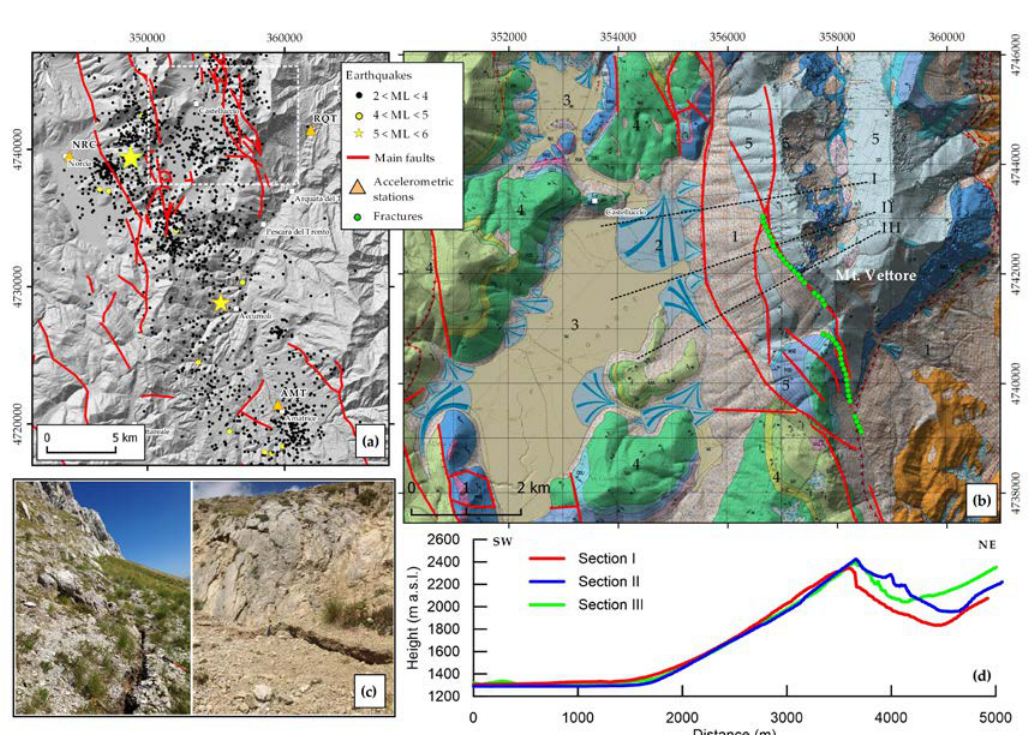
Figure 1: (a) Location of the mainshock and aftershocks. The M W 6.0 mainshock and the M W 5.4 aftershock are represented by yellow stars with red and green stroke, respectively. (b) Detail of Mt. Vettore area (white square in panel a). The numbered lithologies are: 1- Slope deposits; 2- Alluvial deposits; 3- Fluvio-lacustrine deposits; 4- Marly limestones and calcilutites; 5- Limestones and marly limestones (modified from Pierantoni et al. [2013]). (c) Pictures of the observed fractures on Mt. Vettore flank. (d) Topographic profiles along sections I, II and III in panel